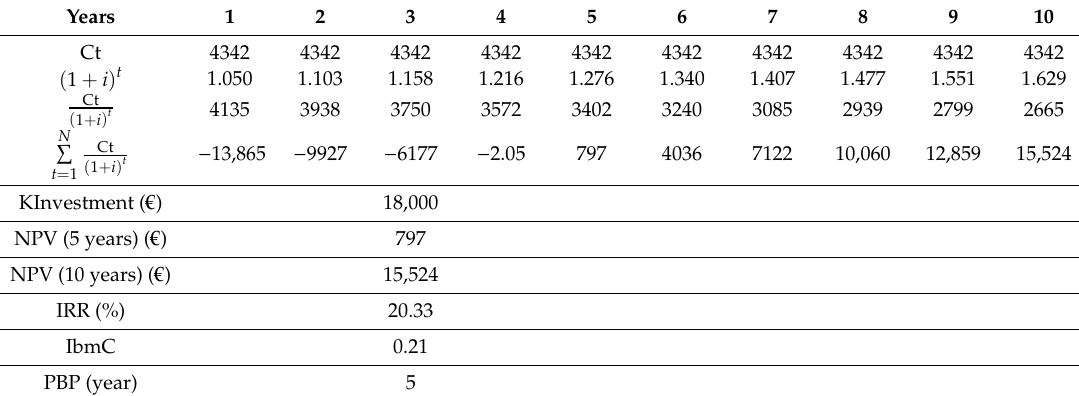
Table 13. Economic analysis results (90% olive and 10% plastic) (Source: own elaboration).